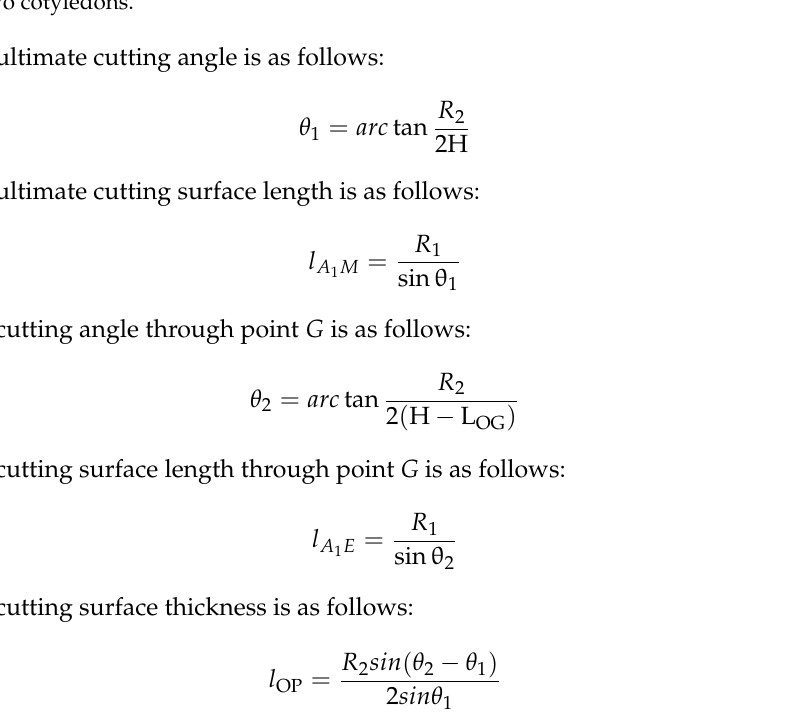
Figure 2. Rootstock cutting model: A 1 is the left base point of the rootstock growing point, A 2 is the right base point of the rootstock growing point, O is the pith cavity vertex, and G is the intersection point of two